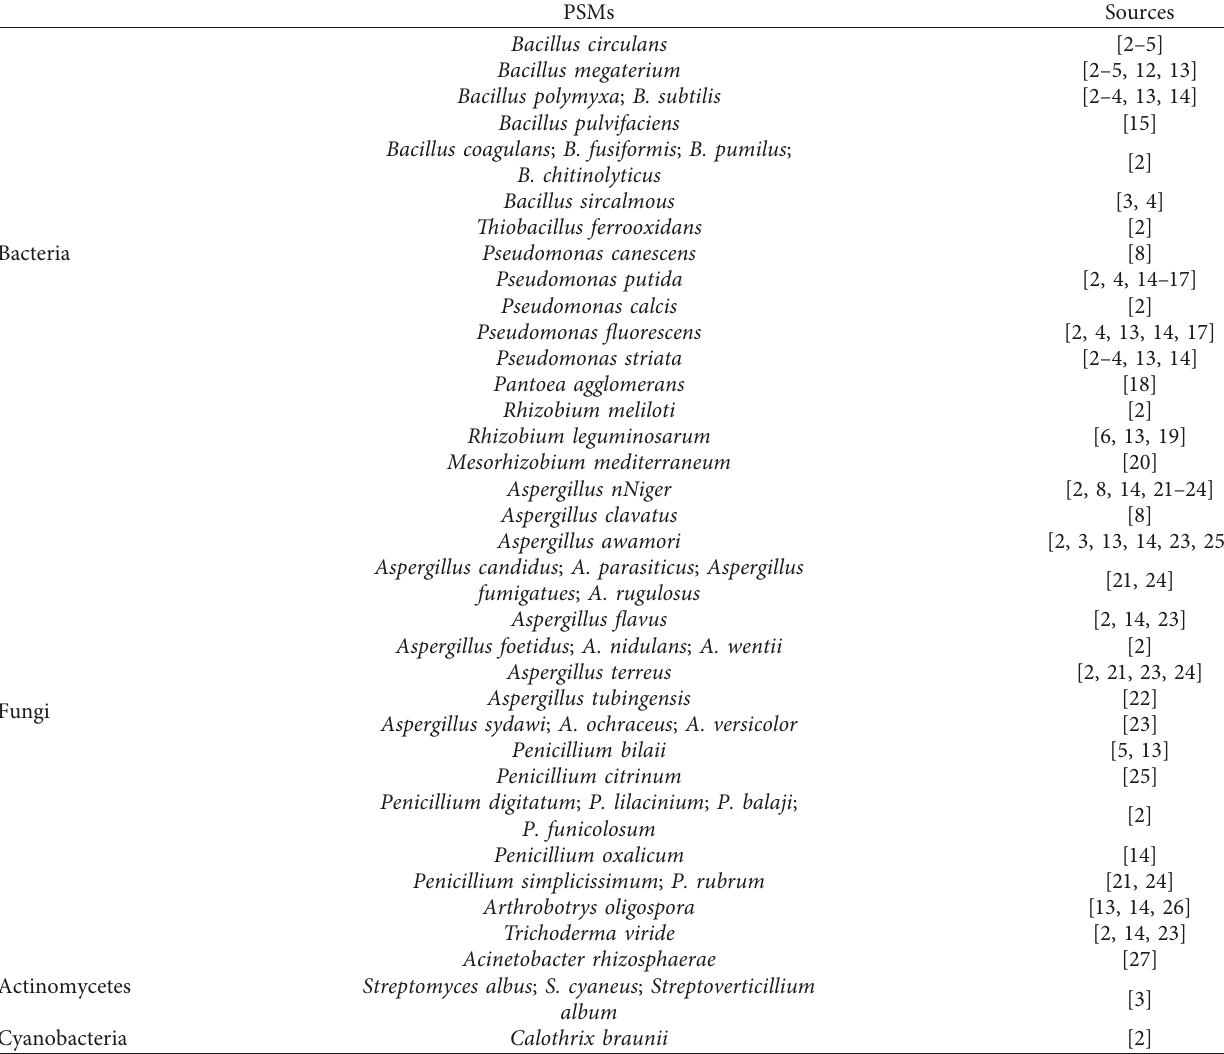
Table 1: Potential P solubilizing